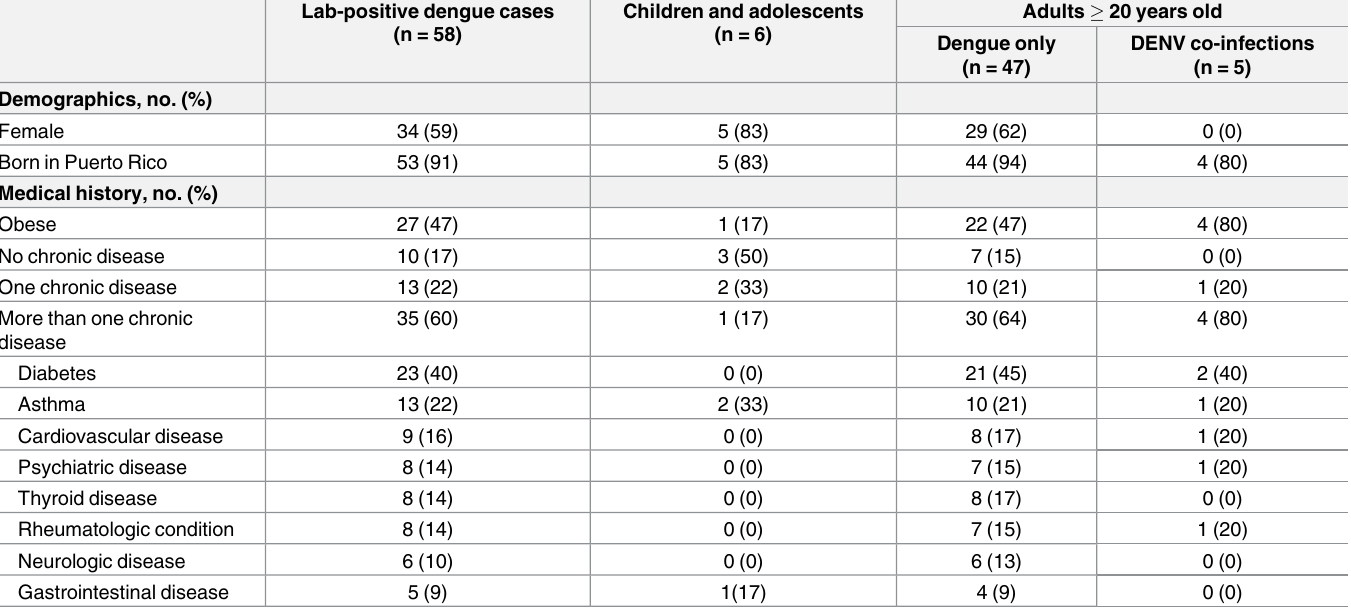
Table 3. Characteristics of all fatal laboratory-positive dengue case-patients detected by the Enhanced Fatal AFI Surveillance System, Puerto Rico,